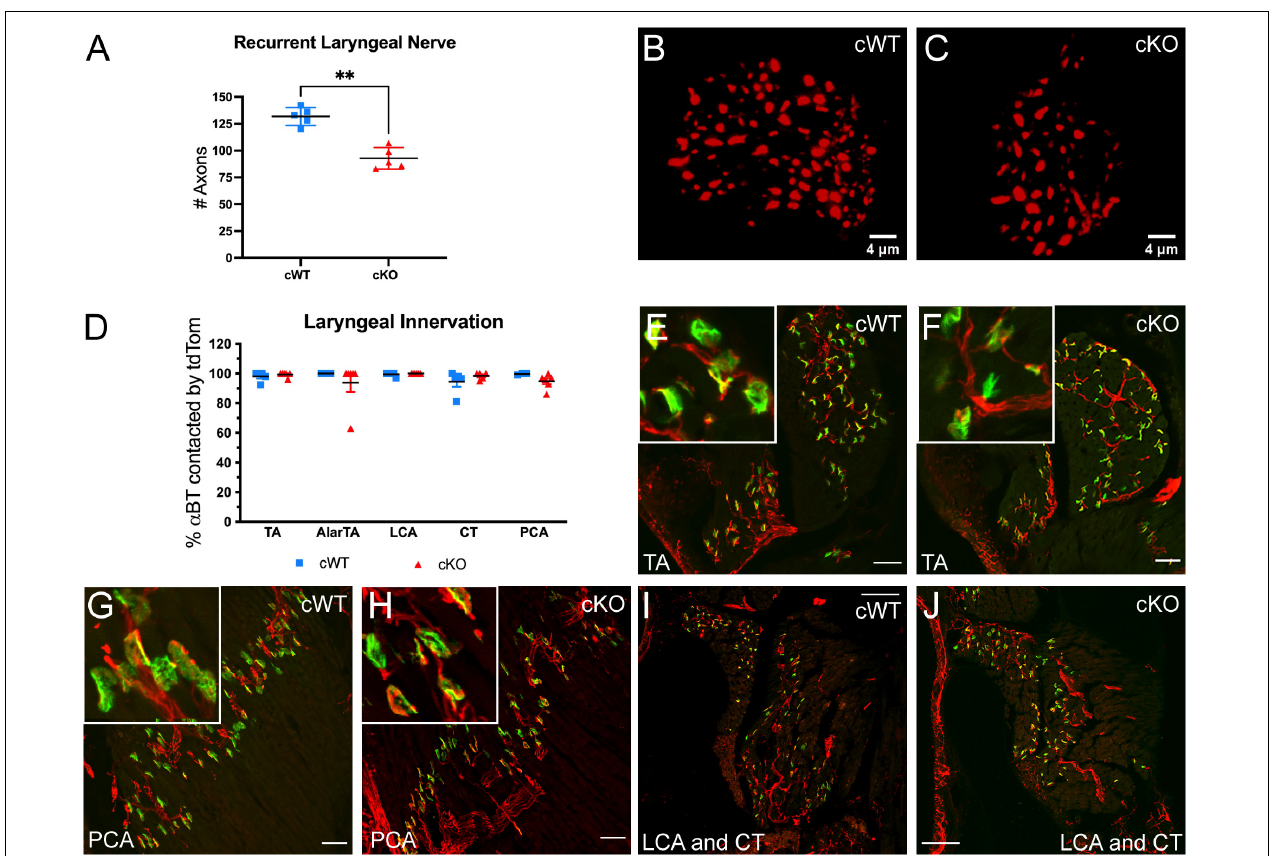
FIGURE 3 | Axonal quantification and innervation status of α BT labeled AChR clusters in laryngeal muscles following MET deletion. (A) Quantification of the number of axons in the recurrent laryngeal nerve in cWT and cKO mice on P7. n = 5 cWT, 5 cKO. t -test, “ ∗∗ ” indicates p ≤ 0.05. (B,C) Representative images of recurrent laryngeal nerve cross sections labeled with neurofilament (red) in cWT and cKO mice on P7. Scalebars = 4 µ m. (D) Quantification of laryngeal motor end plate innervation in cWT and cKO mice on P7. n = 3–5 cWT, 5–6 cKO. Analyzed by two-way ANOVA followed by Sidak correction for multiple comparisons. (E,F) Representative images of tdTom + axons (red) innervating α BT labeled AChR clusters (green) in the thyroarytenoid (TA) muscle of cWT and cKO mice on P7. Insets show enlarged examples of neuromuscular junction morphology. (G,H) Representative images of tdTom + axons (red) innervating α BT labeled AChR clusters (green) in the posterior cricoarytenoid (PCA) muscle of cWT and cKO mice on P7. Insets show enlarged examples of neuromuscular junction morphology. (I,J) Representative images of tdTom + axons (red) innervating α BT labeled AChR clusters (green) in the lateral cricoarytenoid (LCA) and cricothyroid (CT) muscle of cWT and cKO mice on P7. All laryngeal muscle images shown are from tissue sectioned in the coronal plane (prepared along the length of the larynx in sections from dorsal to ventral). Scalebars = 50 µ m in laryngeal muscle sections. The brightness and contrast of each channel was adjusted separately for visualization